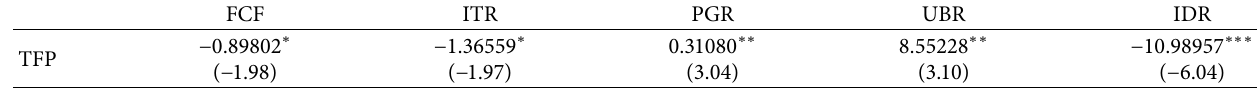
Table 4: Matching between financial system and high-quality economic development.